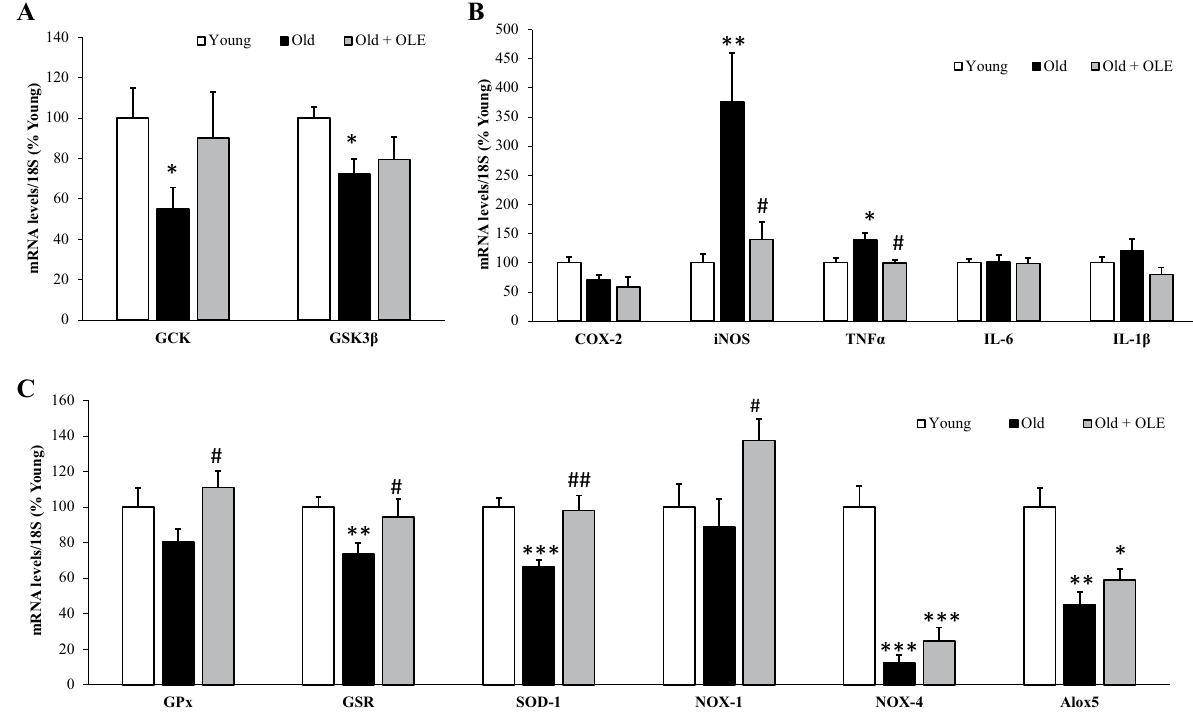
Figure 2. Effects of aging and a 21-day treatment with the OLE on mRNA concentrations of Glucokinase and Glycogen synthase kinase 3β ( A ), ciclooxigenase-2, inducible Nitric Oxide Synthase, Tumor Necrosis Factor α, Interleukin 6 and Interleukin 1β ( B ) and Glutathione Peroxidase, Glutathione Reductase, Super Oxide Dismutase 1, NADPH oxidase 1 and 4, and Lipoxygenase ( C ) in rat livers. Values are represented as mean ± SEM. * p < 0.05 vs. Young; ** p < 0.01 vs. Young; *** p < 0.001 vs. Young; # p < 0.05 vs. Old; ## p < 0.01 vs.